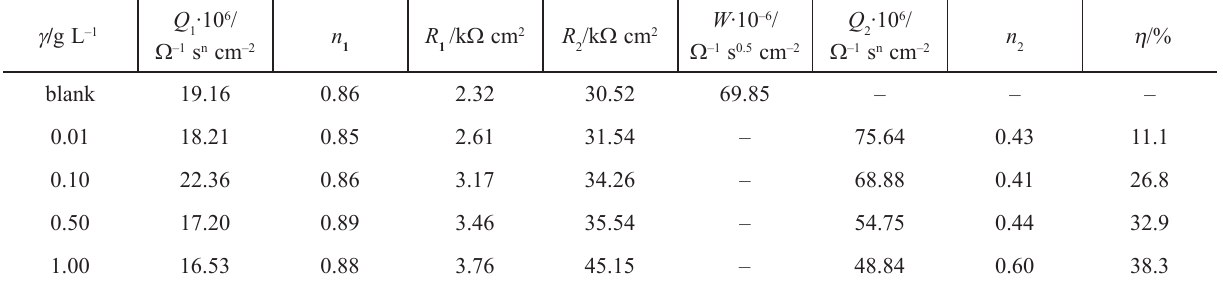
Table 7 – Impedance parameters for Cu electrode in a simulated acid rain solution, pH 4.5, in the presence and absence of HI extracts Q ·10 6 1 g / g L –1